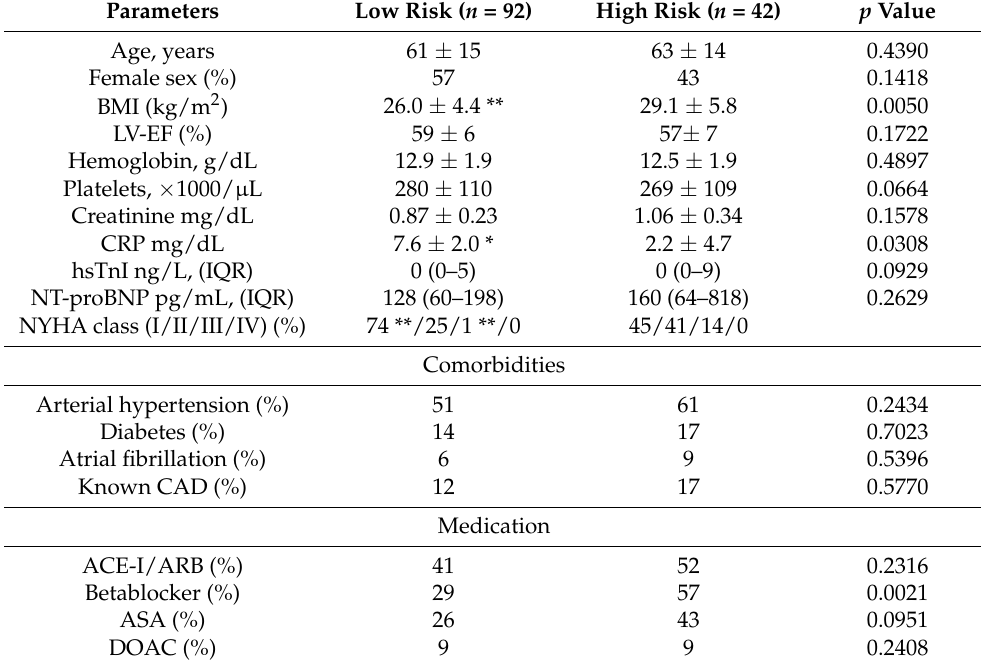
Table 4. Risk group characteristics.